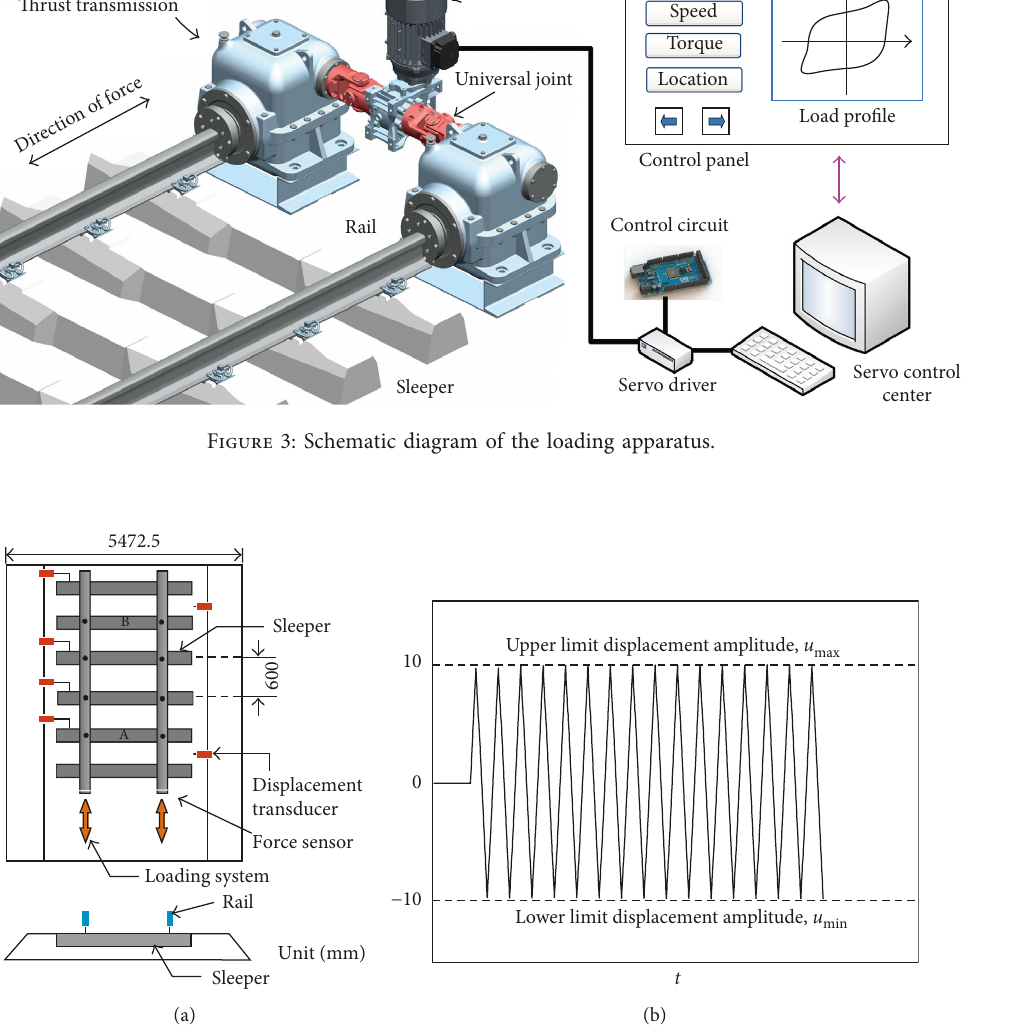
Figure 4: Outline of loading conditions: (a) arrangement of test model and (b) loading